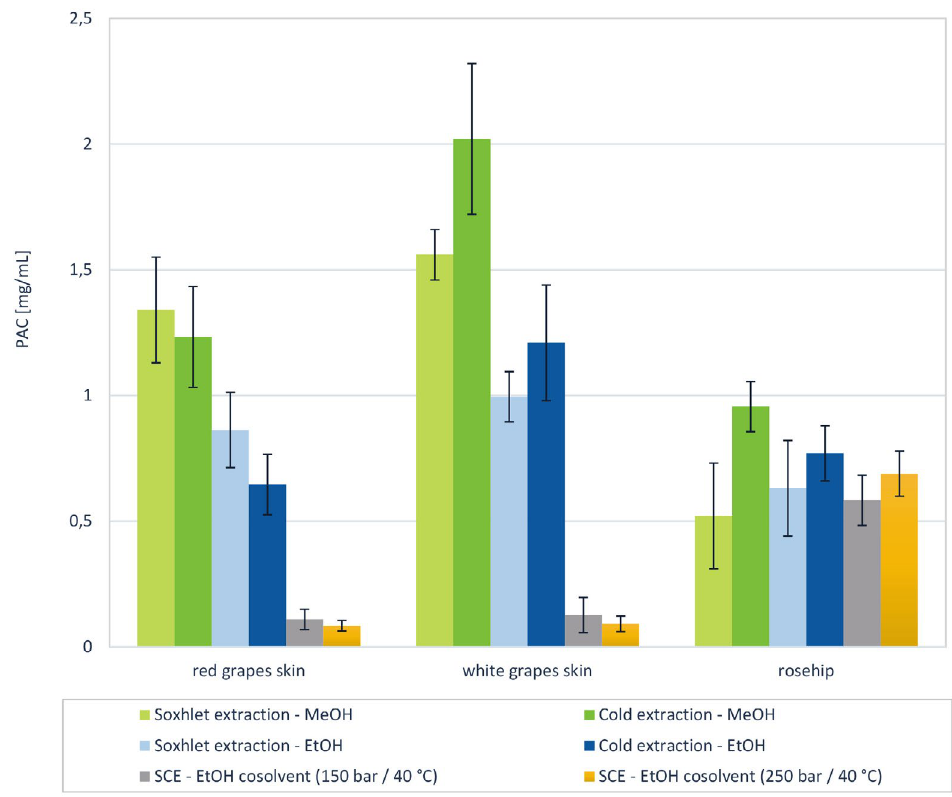
Figure 3: Comparison of proanthocyanins content in extracts obtained by Soxhlet, cold and SC